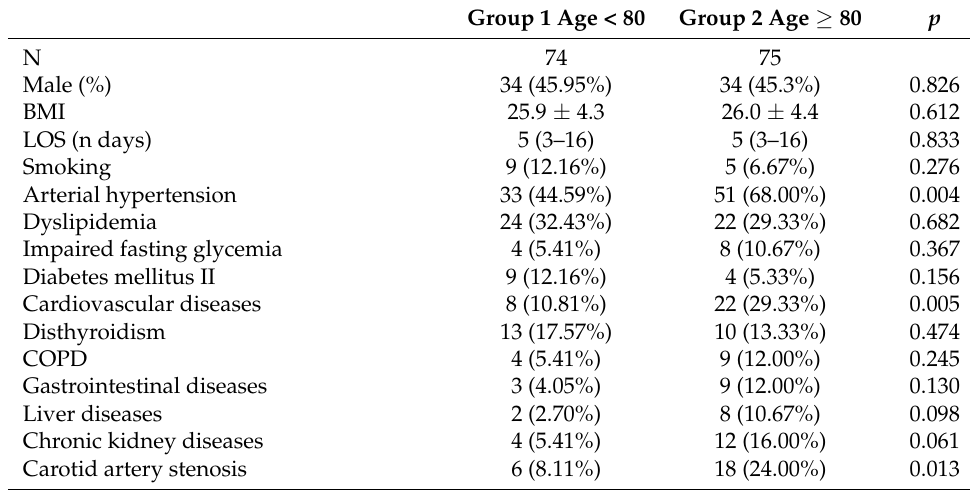
Table 1. Characteristics of the patient population in the two